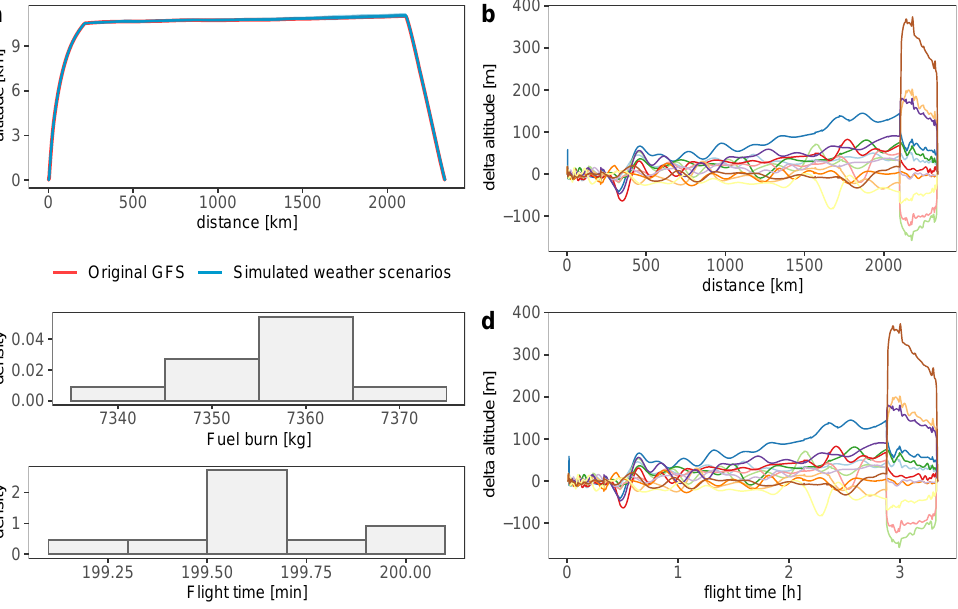
Figure A2. ( a ) The vertical profiles of the trajectories from Nantes to Athens by SOPHIA; red curve: with GFS data; blue curve: with simulated weather scenarios. ( b , d ) The chromatic line plots present the altitude differences between trajectories with simulated weather scenarios and GFS input. ( c ) Total fuel burn and flight time of 11 trajectories with simulated weather